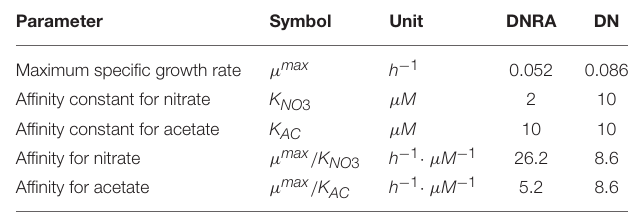
TABLE 7 | Parameter values used for modeling denitrification and ammonification in a chemostat